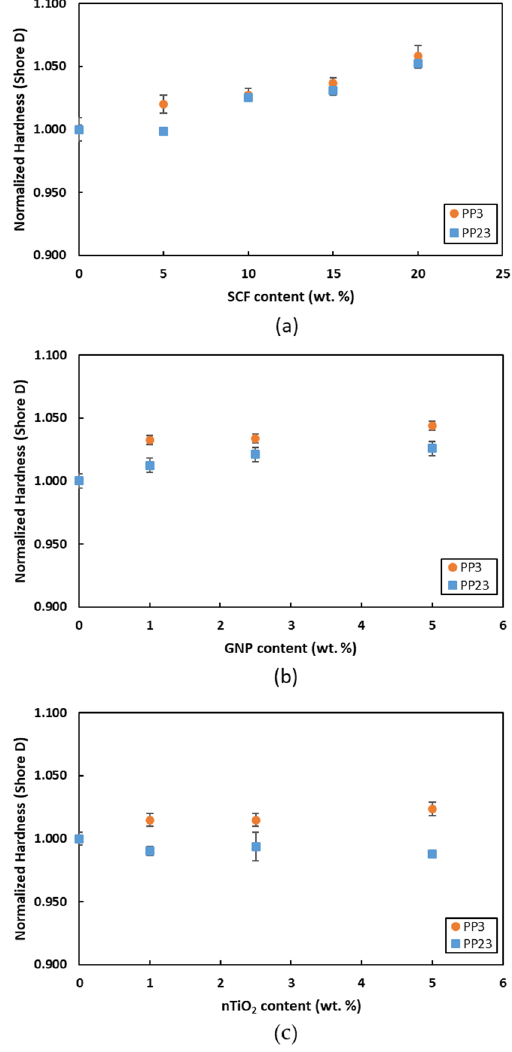
Figure 16. Normalized hardness (Shore-D) of ( a ) PP/SCF, ( b ) PP/GNP, and ( c ) PP/nTiO 2 composites.